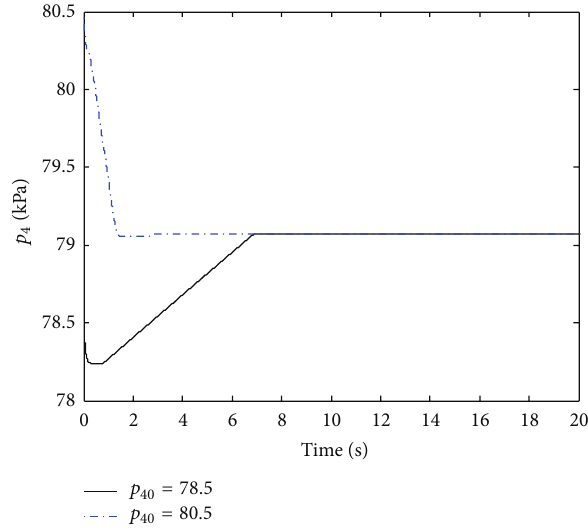
Figure 6: Phase plane trajectories of cabin pressure 𝑝 4 after parameters modification.